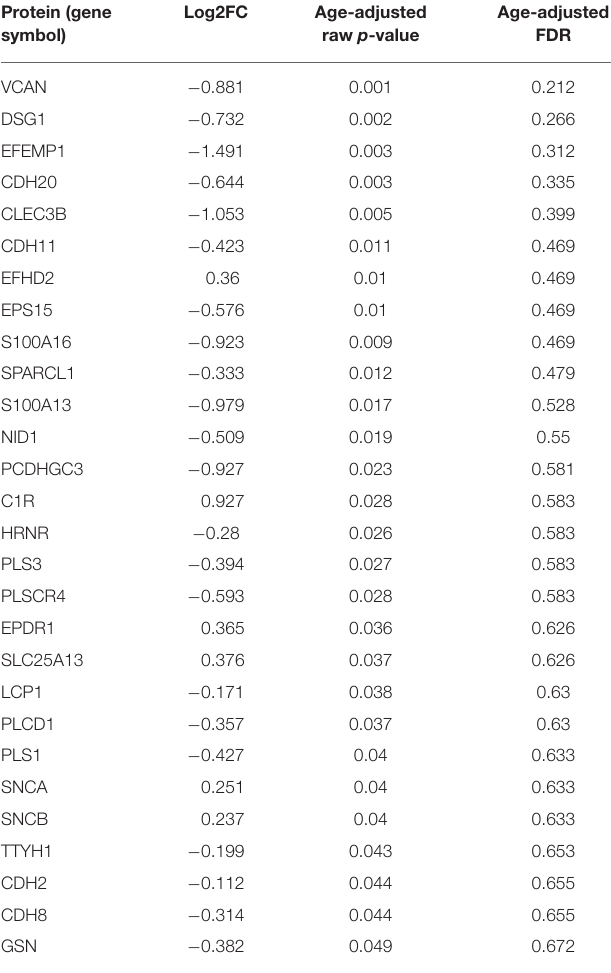
DAP, differentially abundant protein.